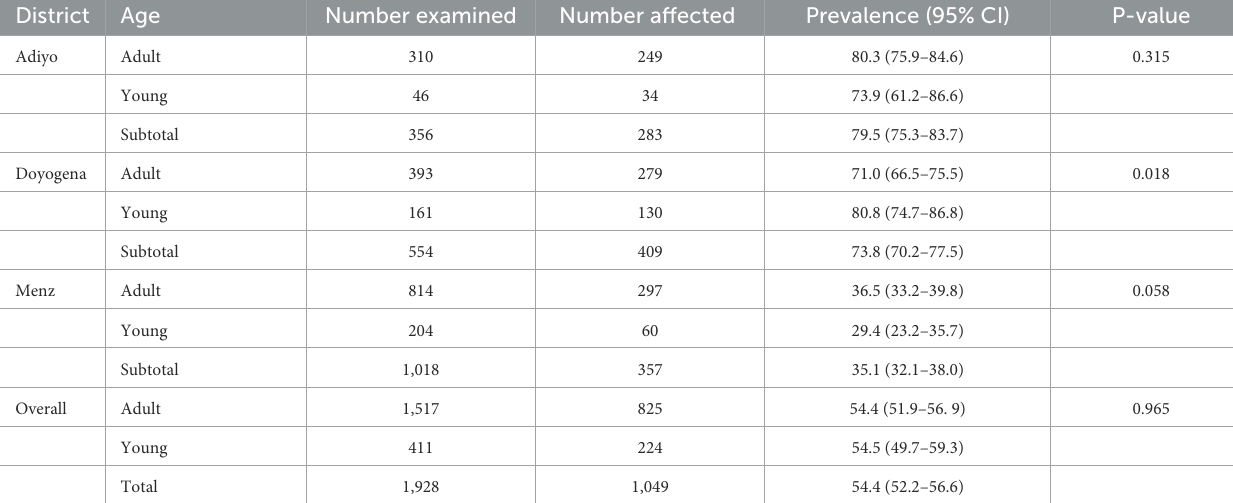
TABLE 1 The percentage of sheep with GIT parasite eggs of any species detected in their feces, by district, data from all years pooled.